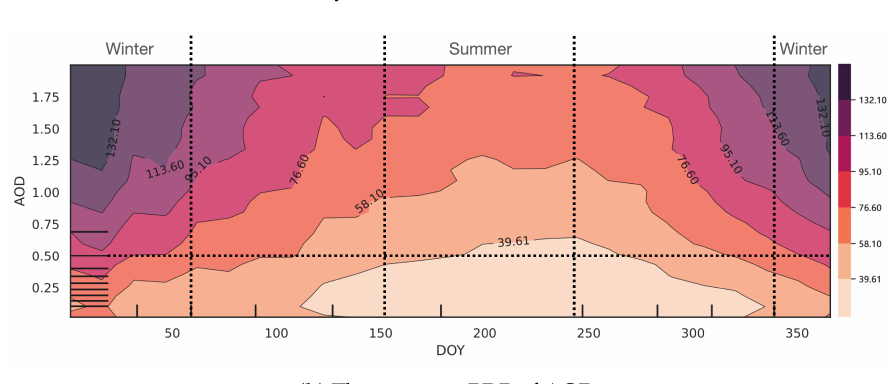
Figure 8. ( a ) The one-way partial dependence plots (PDP) of aerosol optical depth (AOD) in the Beijing-Tianjin-Hebei and the Sichuan Basin during summer and winter. The dotted line represents the estimated PM 2.5 concentration when AOD is 0.5. ( b ) The two-way PDP of AOD. The contour lines on the subfigure ( b ) represent the average estimated PM 2.5 concentrations ( µ g m − 3 ). The black bars on the axes show the deciles of the feature values in the training